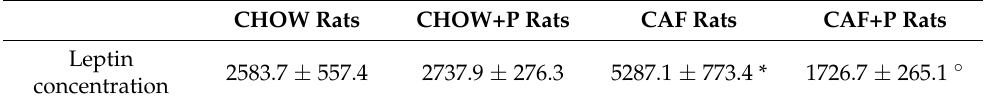
Table 2. Leptin concentration in blood at the end of the experiment (day